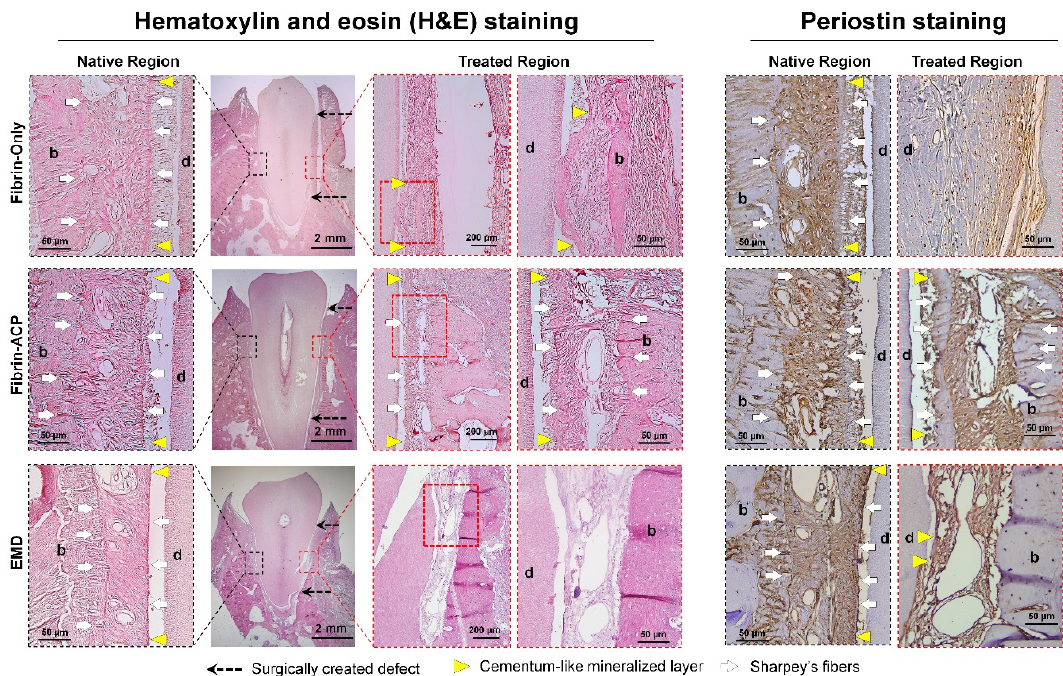
Figure 9. Histological and immunohistological analyses of cementum formation and Sharpey’s fiber insertions to bone and newly formed cementum tissues. Compared with fibrin-only (unmodified fibrin hydrogel) and enamel matrix derivative (EMD) groups, the fibrin-ACP (modified fibrin hydrogel) facilitated the regeneration of periodontal tissues such as cementum on tooth-root surfaces, PDL, and the alveolar bone. More critically, the fibrin-ACP promoted Sharpey’s fiber formations and insertions into the cementum layers and alveolar bone surfaces, indicated by white arrows. (d: tooth-root dentin; b: bone). Adapted with permission from the reference [12].